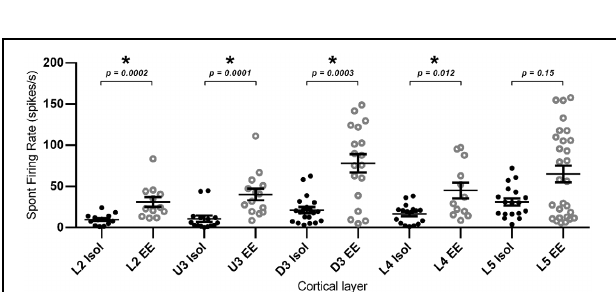
stimulus amplitudes, plotted across all cortical layers. The average PFR EE / PFR Isol ratio is highest in supragranular layers for all stimuli, and decreases as cortical depth increases. Laminar designations: L2, Layer 2; U3, Upper Layer 3; D3, Deep Layer 3; L4, Layer 4; L5, Layer 5. Symbols corresponding to the five stimuli are presented in the keys to the right of the figure.